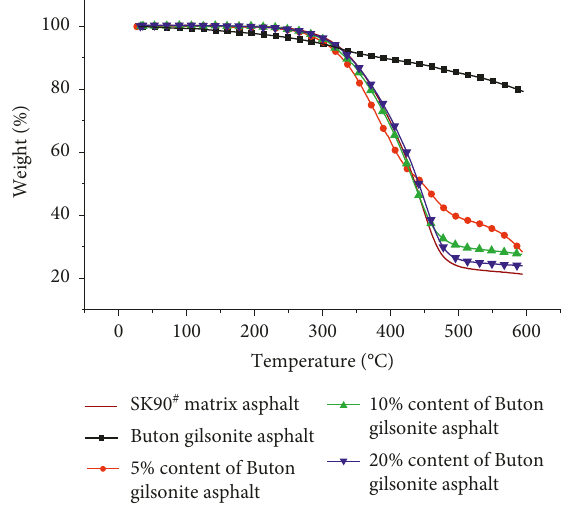
Figure 15: Thermogravimetric test